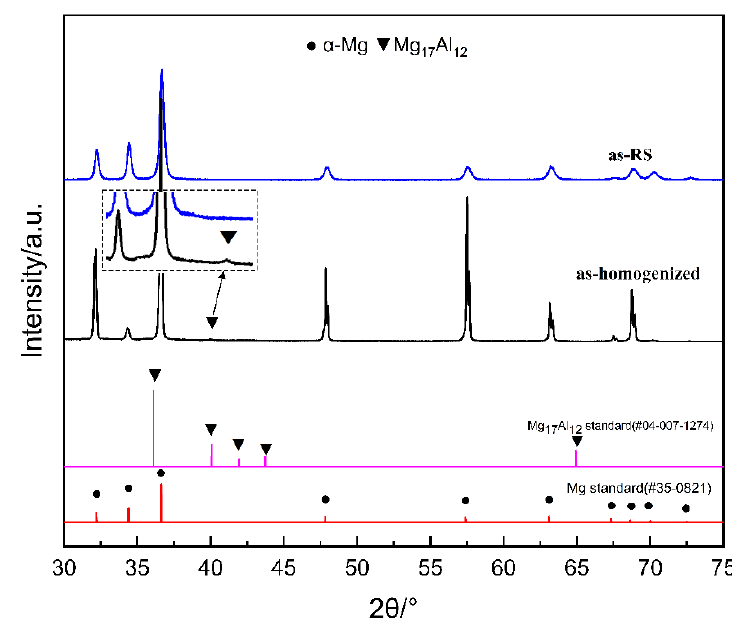
Figure 3. The XRD patterns of as-homogenized and as-RS AZ31B alloys.